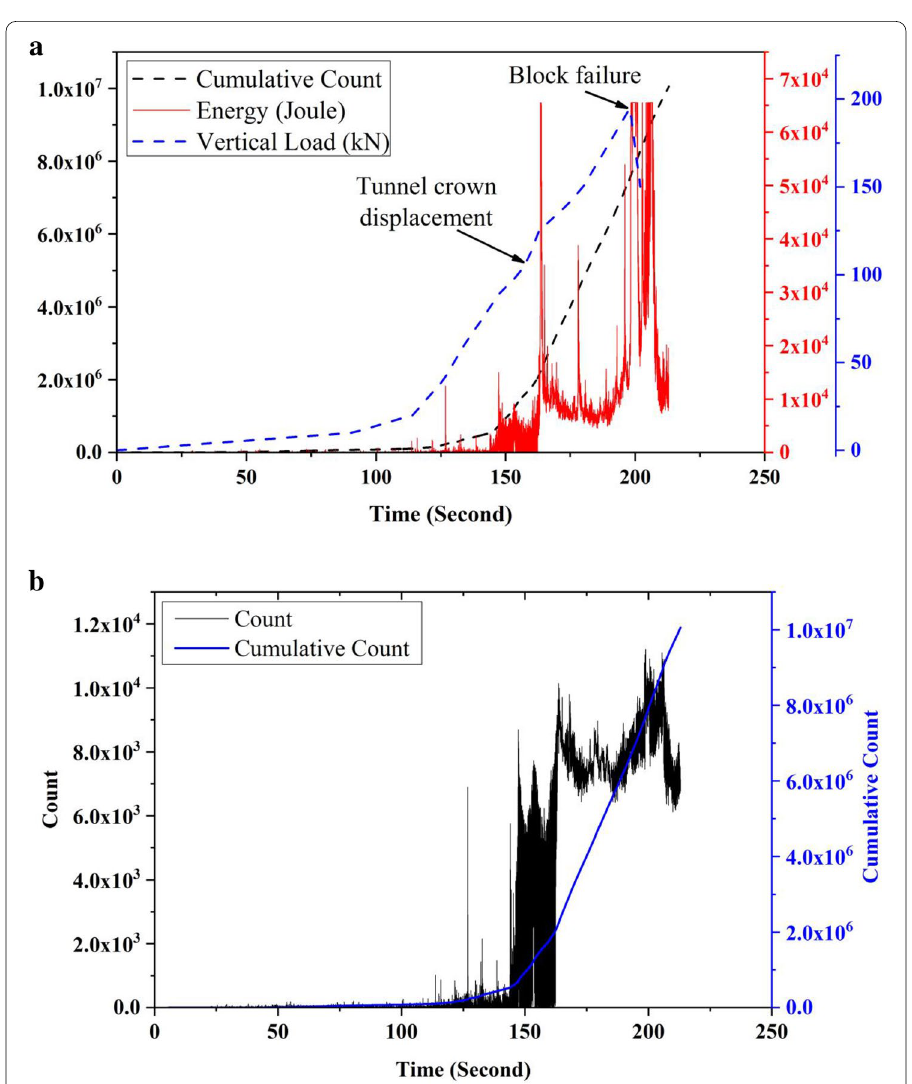
Fig. 9 Vertically layered block, a Plot showing the acoustic behavior and load vs time ( b ) Count and cumulative count vs